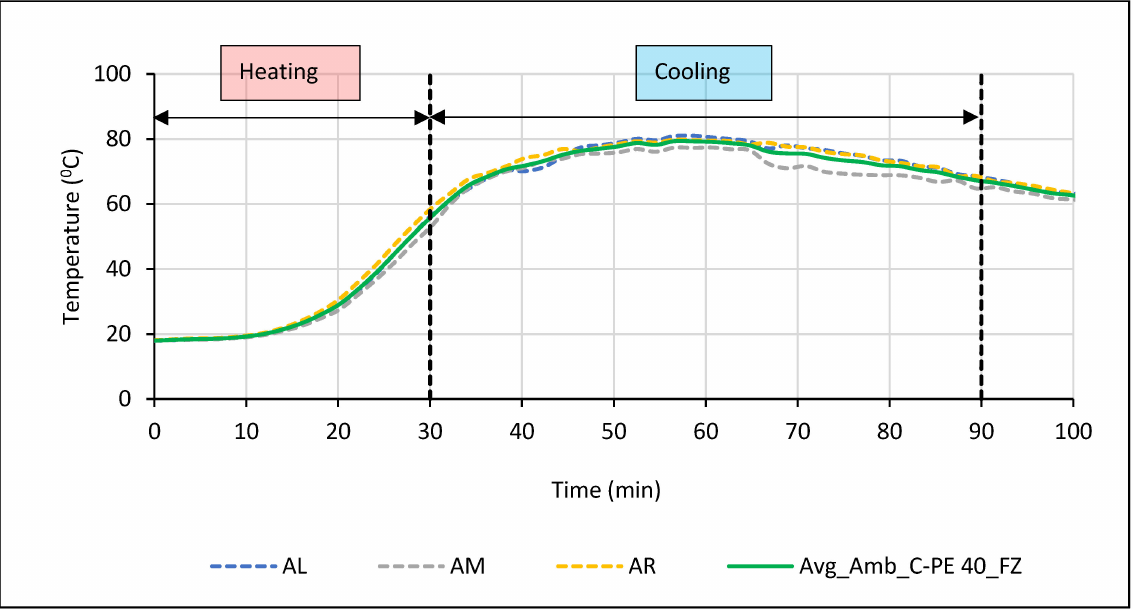
Figure 27. Ambient side surface time–temperature curves of C-PE 40 block from the bushfire